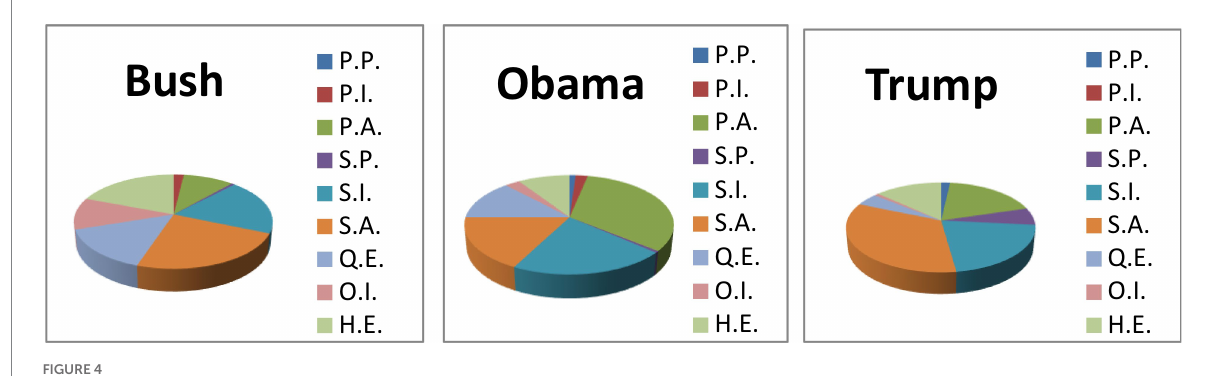
FIGURE 4 The distribution of types of evidentials in three cases.